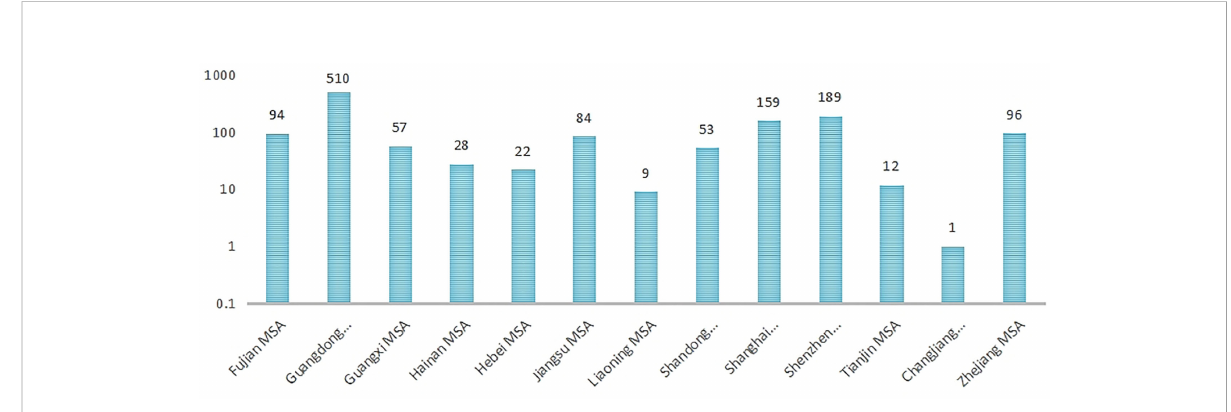
FIGURE 2 Comparison of administrative punishment cases in various maritime authorities. Source: The website of Maritime Safety Administration of the P. R. C and local Maritime